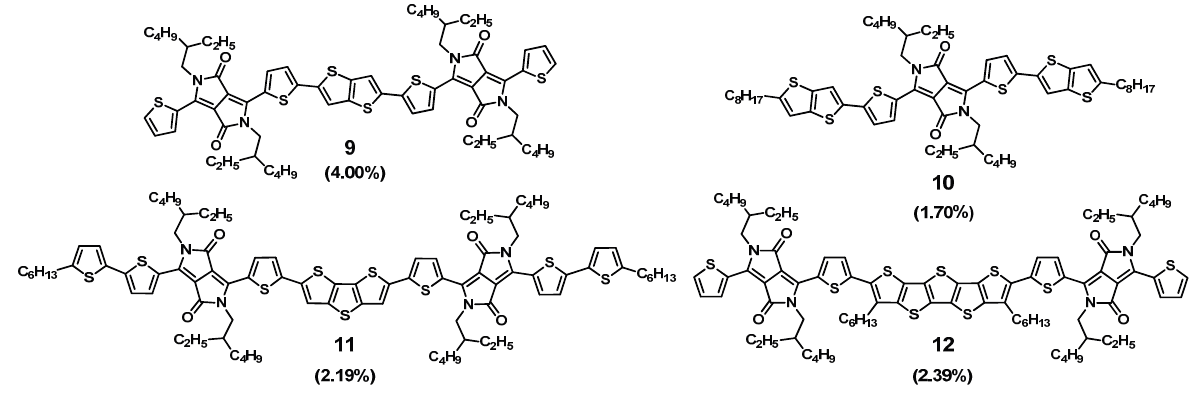
Table 1. Photophysical and photovoltaic performance of organic photovoltaics (OPVs) based on fused-thiophene containing organic semiconductors.